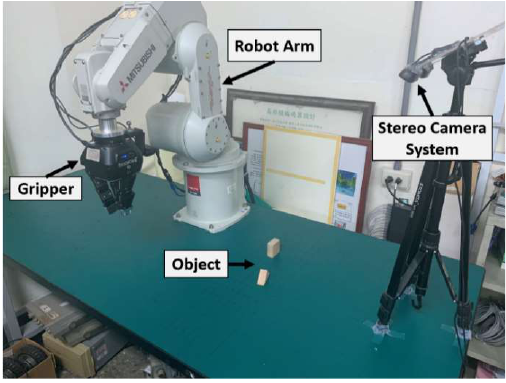
Figure 7. Stereo camera, robot arm, gripper, and their working space.